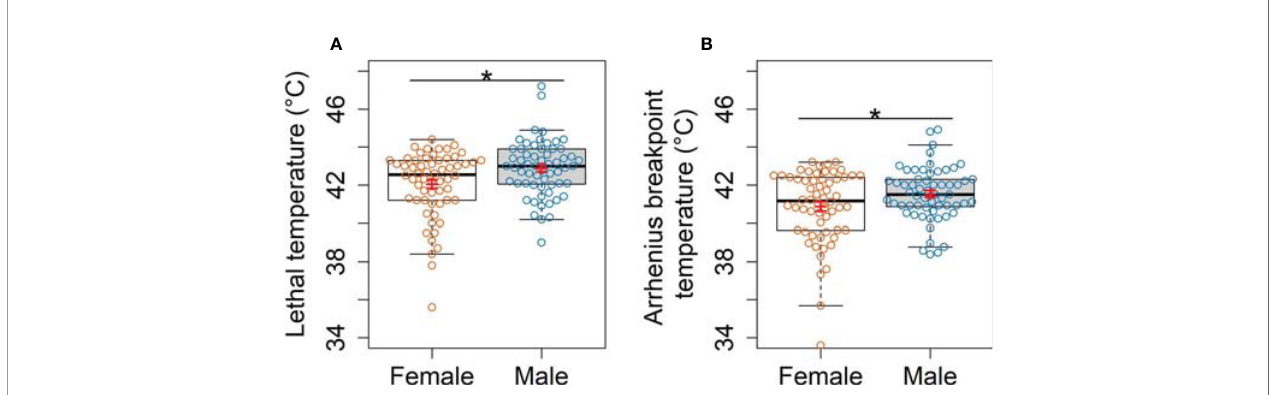
FIGURE 5 | Comparisonof: (A) Lethaltemperatureand (B) ArrheniusBreakpointtemperaturebetweenmaleandfemale fi ddler crabs. Boxplotsshow themedian, 25thand 75thpercentiles, andwhiskersare 1.5timesthespreadbeyondthehinge.Whiteandgreyboxesrepresentfemalesandmales,respectively.Orangeandbluecirclescharacterize raw datapointsfor femalesandmales, respectively. Redlinesshowmeanandstandarderrors. Asterisks denote signi fi cantdifferences(PERMANOVA, p<0.05).